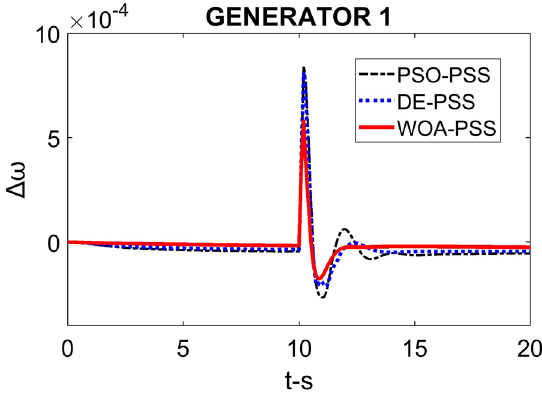
Fig. 13 Speed deviatio n of G1 under 3- φ fault at t = 10